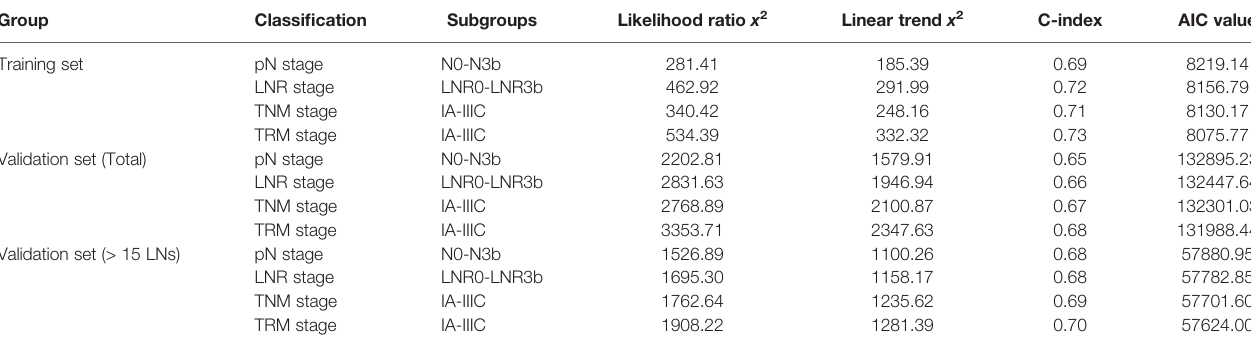
TABLE 5 | Comparison of the performance of the AJCC TNM staging system and TRM staging system.